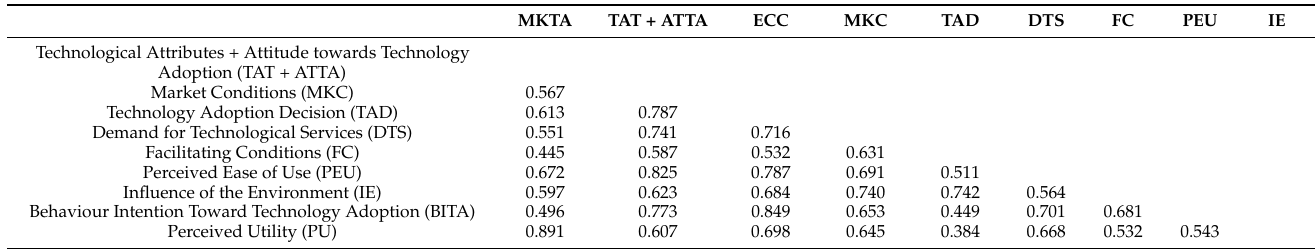
Table 4. Discriminant validity: Heterotrait–Monotrait Ratio.